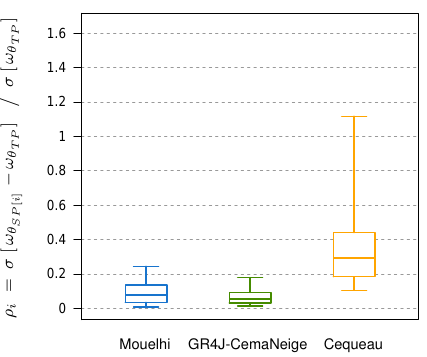
Fig. 7. Behavioural similarities observed between sub-period and full record calibrations in terms of 10yr mean flow volume errors (distribution for each model over 20 catchments).